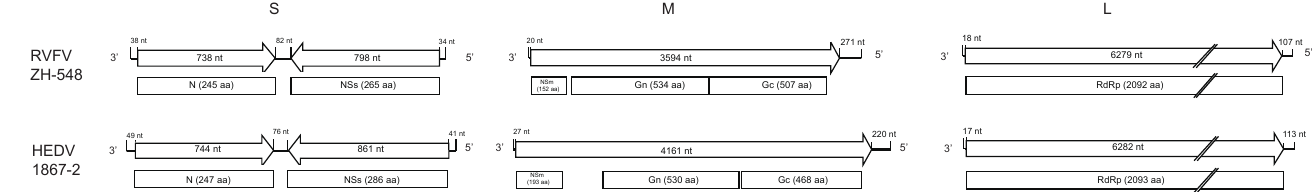
Figure 1. Schematic of the genome organization of HEDV1867-2 and Rift Valley fever virus strain ZH-548. Lines represent gene segments; arrows represent coding regions; and boxes represent transcribed proteins. The full lengths of the three gene segments of HEDV1867-2 and the deduced ORFs are 3 to 567 nt longer than those of ZH-548. The amino acids encoding the HEDV1867-2 proteins, except for glycoproteins Gn and Gc, which are 4 aa and 39 aa shorter, respectively, were 1 to 41 aa longer than those of ZH-548, and the non-structural proteins NSs and NSm were 21 and 41 aa longer,